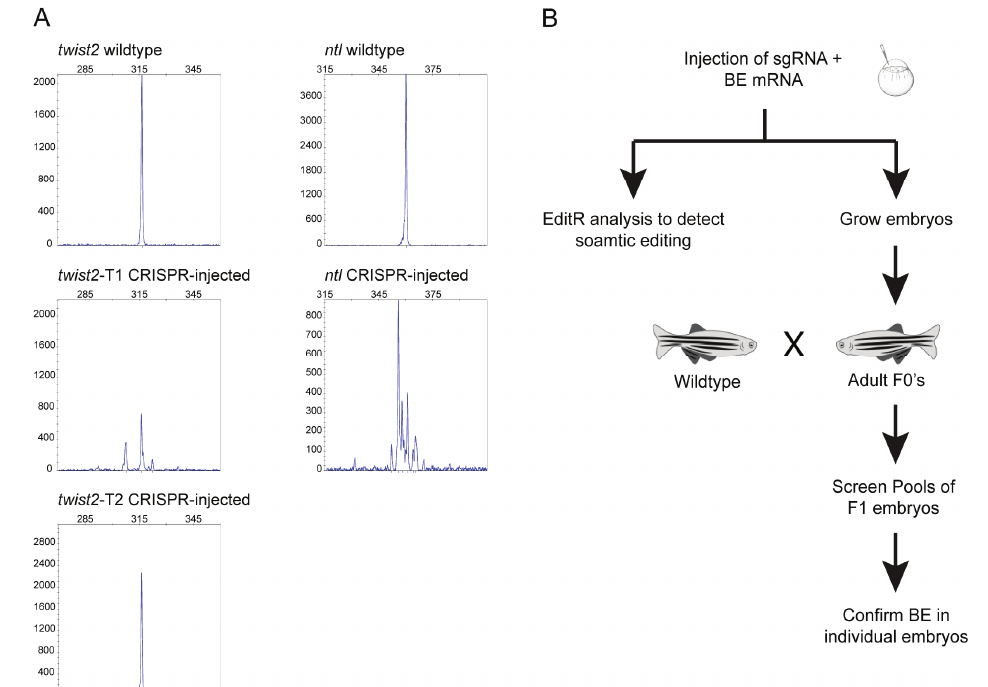
Figure 2. Selection of targets and strategy for assessment of base editing e ffi ciency. ( A ) Evaluation of sgRNA targets by CRISPR-STAT. Peak profiles from representative wildtype (uninjected) or sgRNA-injected embryos are shown. twist2 -T1 and ntl sgRNAs showed multiple peaks indicating DSB / NHEJ repair, whereas twist2 -T2 showed no DSB / NHEJ activity. ( B ) Schematic of workflow for screeningzebrafishatthesomaticandgermlinelevels. Injectedembryoswerescreenedusingsequencing and EditR analysis for somatic base editing and additional progeny were grown to adulthood. Adult fish were then screened for germline transmission by outcrossing with wildtype fish and screening by